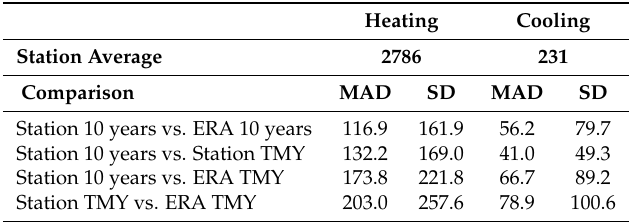
Table 2. Average number of Heating Degree Days (HDD) and Cooling Degree Days (CDD), and statistical deviation (Mean Absolute Deviation, MAD, and Standard Deviation, SD) between different data sources calculated according to Equations (5) and (6).